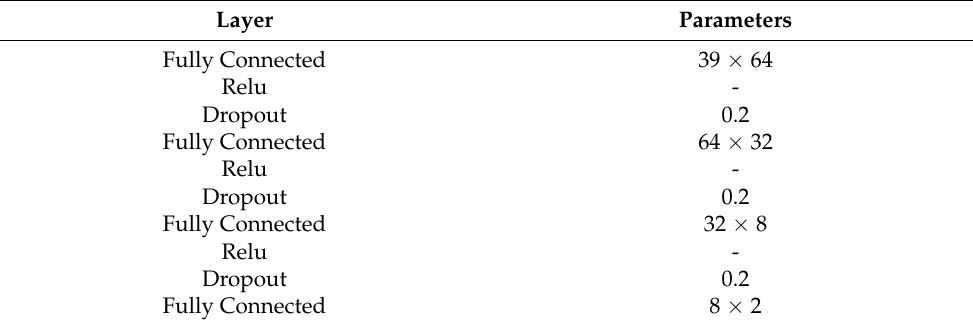
Table 2. The fully-connected neural network structure.